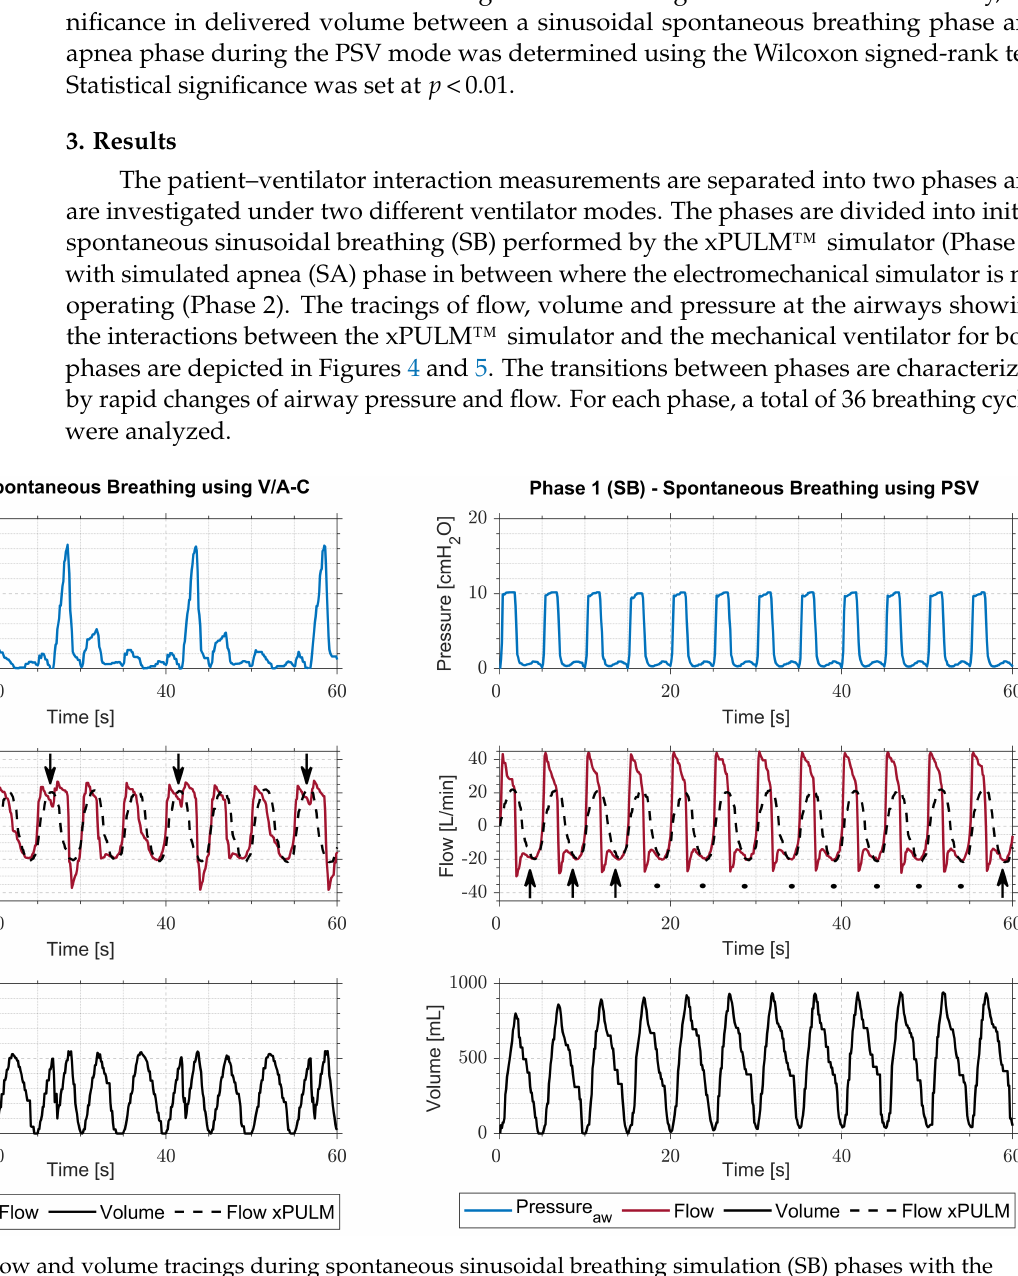
Figure 4. Pressure, flow and volume tracings during spontaneous sinusoidal breathing simulation (SB) phases with the xPULM™ and mechanical ventilator BellaVista™ in the V/A-C mode ( left ) and in the PSV mode ( right ). Simulated patient’s breathing frequency is not in phase with the ventilator’s frequency representing realistic conditions. This leads to trigger asynchrony (double-triggering) in the V/A-C mode (arrows on the left) and trigger asynchrony (premature cycling) in the PSV mode (arrows on the